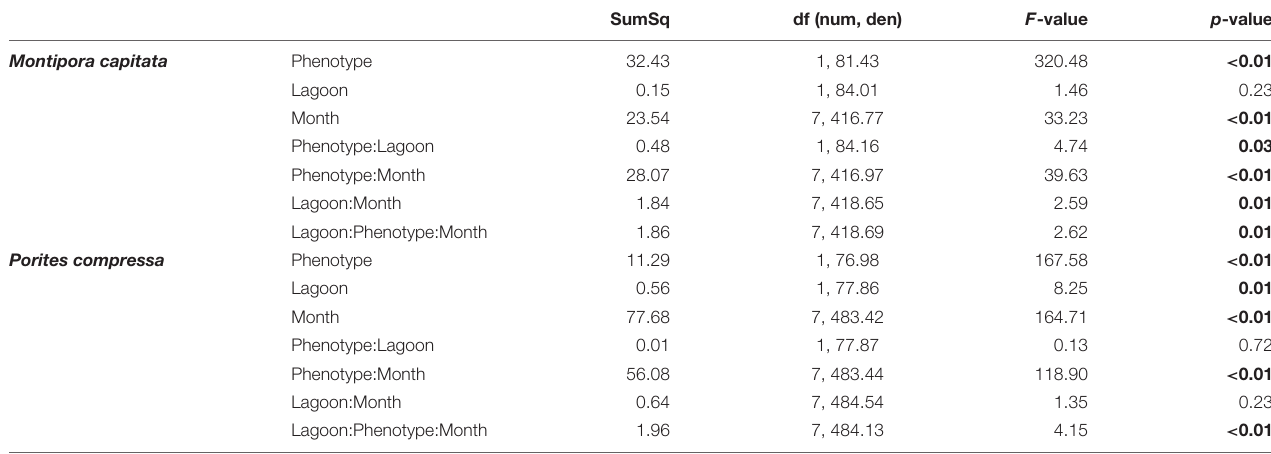
FIGURE 5 | Average color score (A–D) and partial mortality (E–H) of bleaching susceptible versus bleaching resistant colonies of Montipora capitata (A,B,E,F) and Porites compressa (C,D,G,H) at the Inner Lagoon (A,C,E,G) and Outer Lagoon (B,D,F,H) from the peak of the coral bleaching event (September–October 2015) through the following 24 months of recovery. Solid lines indicate bleaching resistant colonies; dashed lines indicate bleaching susceptible colonies. Color scores: 1, white; 2, pale; 3, pigmented. Error bars indicate SEM. TABLE 2 | Type II Analysis of Variance Table with Satterthwaite approximation for the effects of bleaching phenotype, lagoon, and recovery time across the course of the study, on pigmentation recovery of bleaching susceptible and resistant colonies for Montipora capitata and Porites compressa at Inner and Outer lagoons (Color Score ∼ Phenotype × Lagoon × Month + (1|Coral Tag